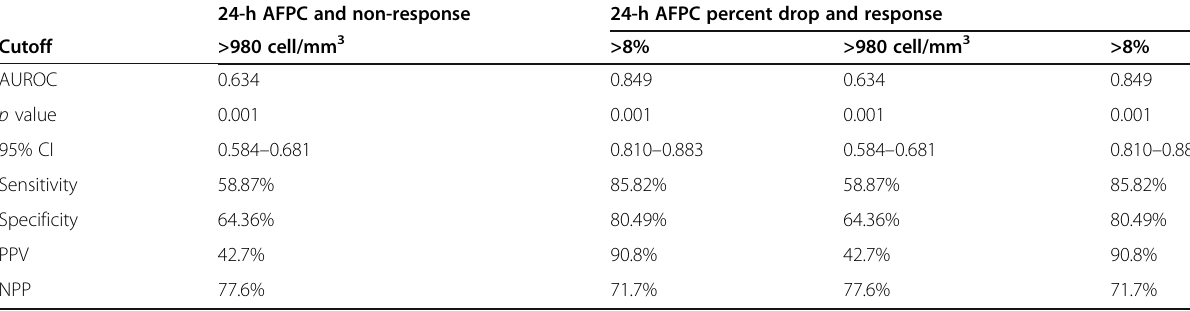
Table 2 Relation between 24-h AFPC and type of treatment response in SBP patients